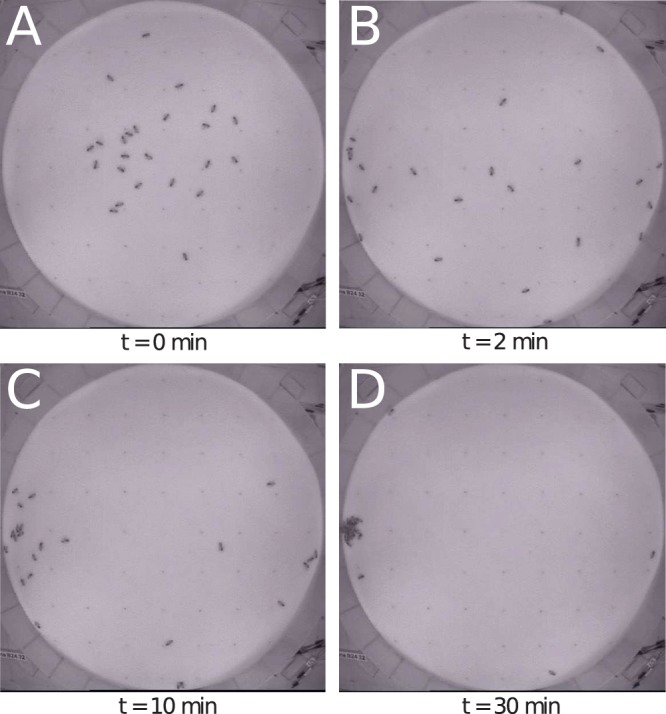
Pictures of an exemplary experimental run at different times.(A) minute 0: start distribution, (B) minute 2: dispersal, (C) minute 10: start of aggregation in optimum, (D) minute 30: aggregation at 36±1°C. The corresponding complex gradient is depicted in figure 3.